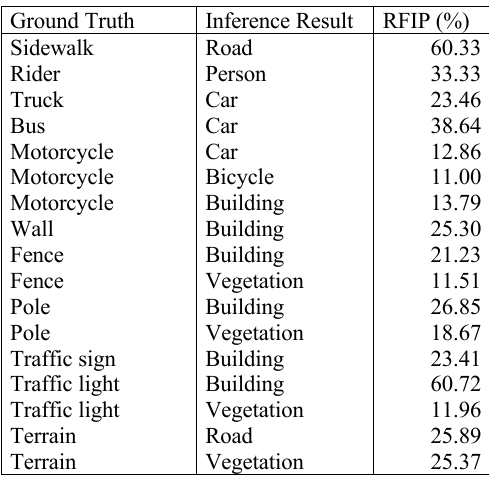
Table 4 . List of the pairs with RFIP values higher than 10%.